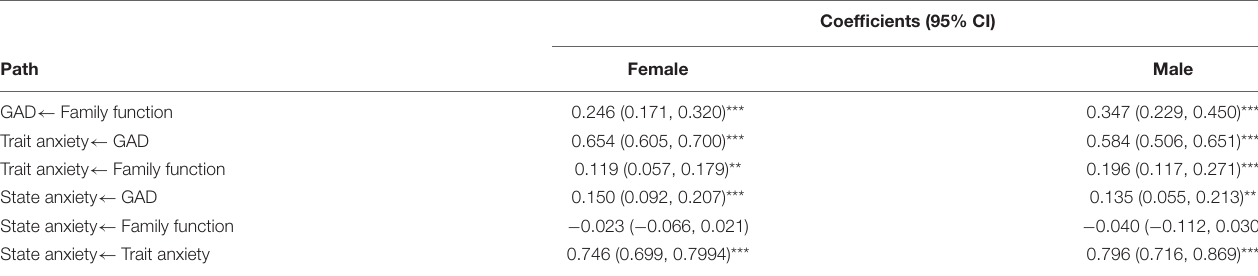
Coefficients (95%